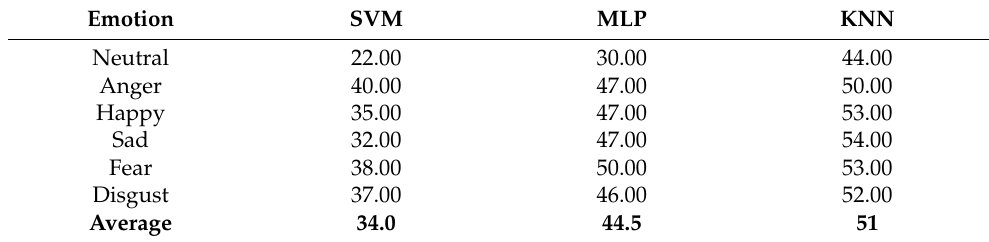
Table 5. Percentage EER using SVM, MLP, and KNN classifiers using Crema-D.